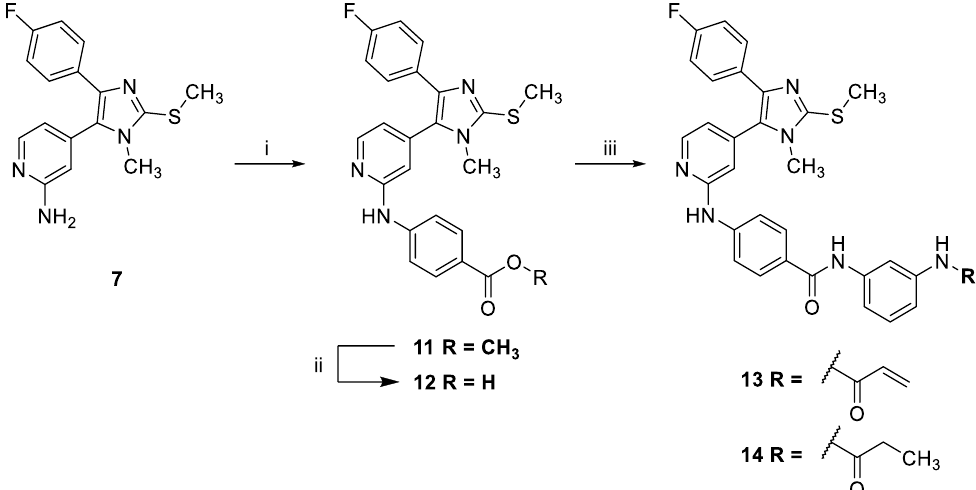
Scheme 2. Synthesis of inverse amide derivatives 13 and 14 . (i) Methyl 4-bromobenzoate, BrettPhos Pd precatalyst, Cs 2 CO 3 , 1,4-dioxane/ t BuOH, Ar, 115 °C, 16 h, 73%; (ii) LiOH in THF/MeOH/H 2 O, r.t., 37 h, 95%; (iii) 12 , N -(3-aminophenyl)acrylamide in the case of the synthesis of 13 or N -(3-amino- phenyl)propionamide in the case of the synthesis of 14 , HATU, DIPEA, DCM, r.t., 22 – 27 h, 43 – 52%.